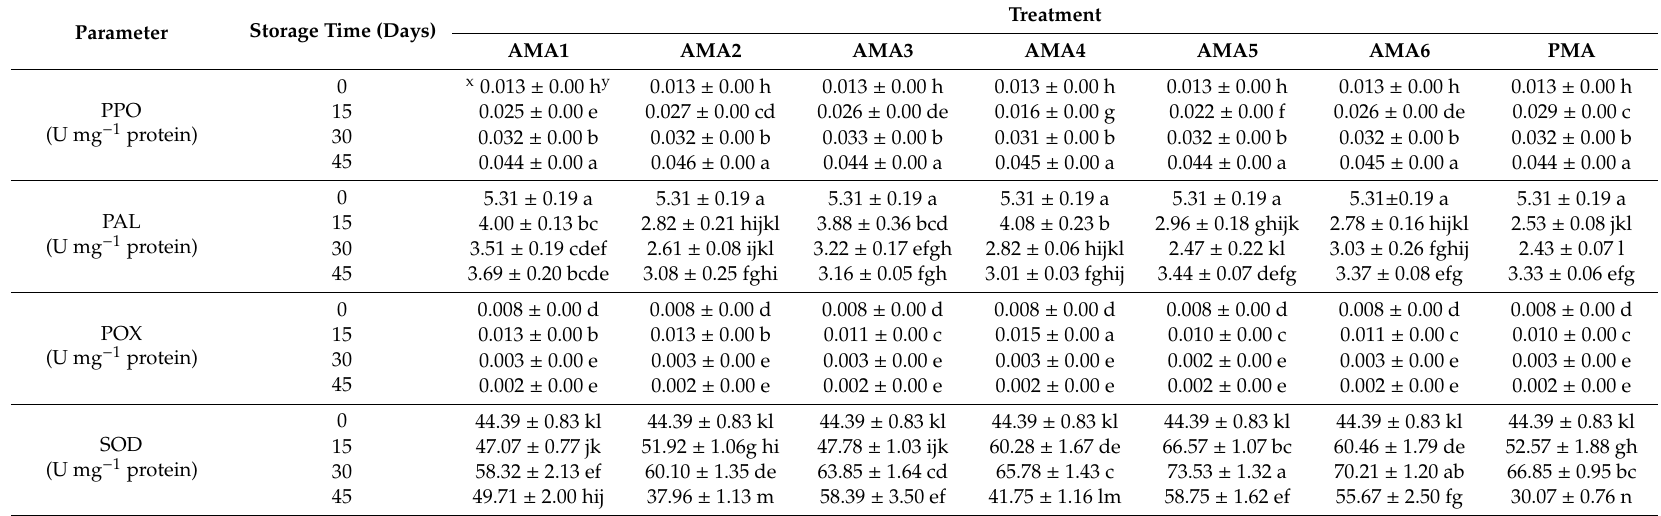
Table 5. E ff ect of di ff erent AMA and PMA conditions on the polyphenol oxidase (PPO), phenylalanine ammonia-lyase (PAL), peroxidase (POX), and superoxide dismutase (SOD) activity in the hulls of fresh pistachios stored for 45 days at 4 ± 1 ◦ C and 90 ± 5%